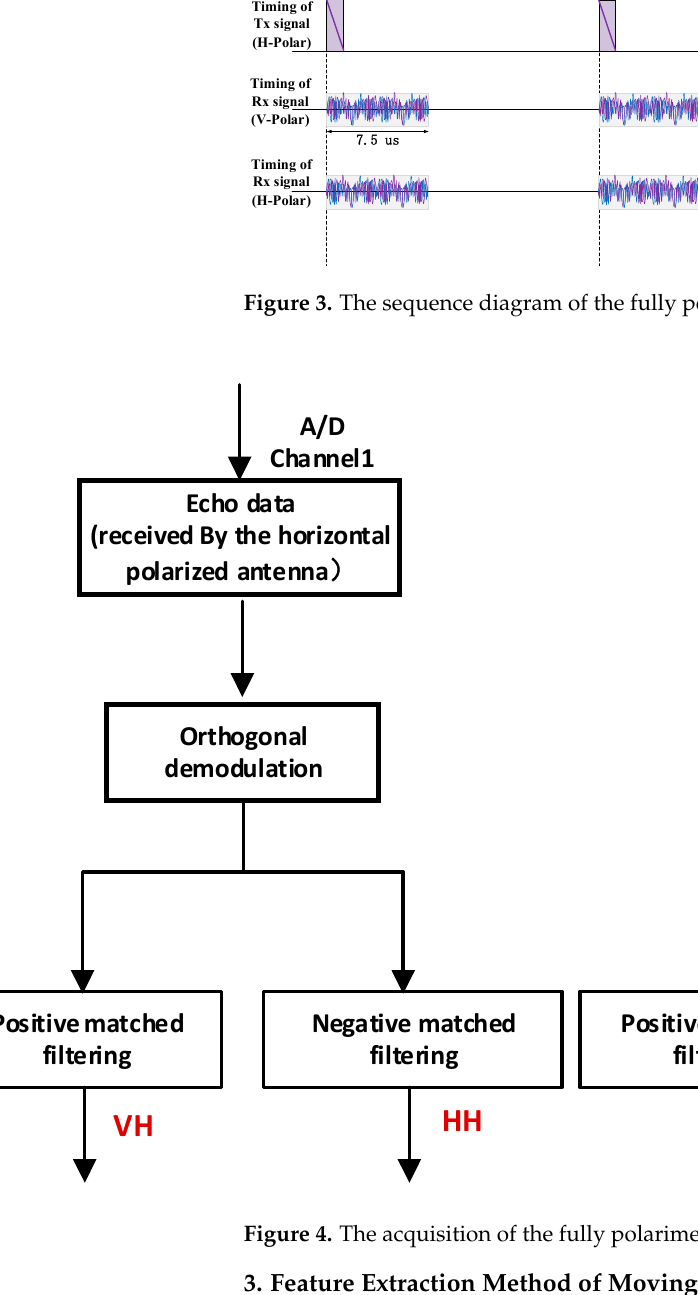
Figure 4. The acquisition of the fully polarimetric radar echo.